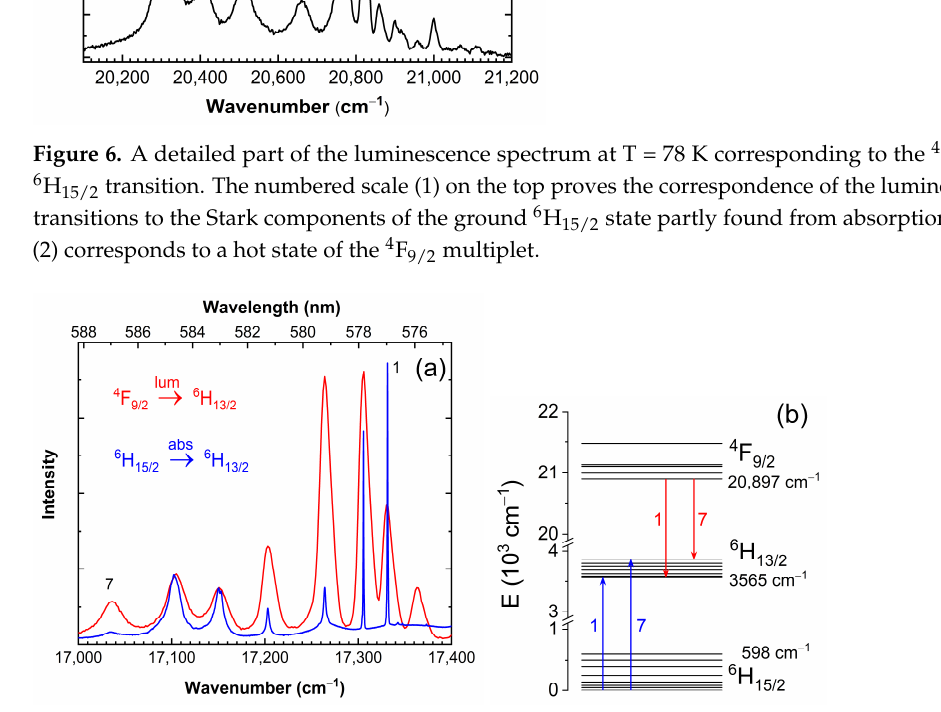
Figure 7. ( a ) The 4 F 9/2 → 6 H 13/2 luminescence transitions at T = 78 K (red line) and the absorption spectrum presented in Figure 3a but reversed as described in the text (blue line). ( b ) Part of the energy levels showing the absorption and luminescence transitions. The position of higher energy multiplets of the Dy 3+ ion in Li 6 Y(BO 3 ) 3 may be obtained